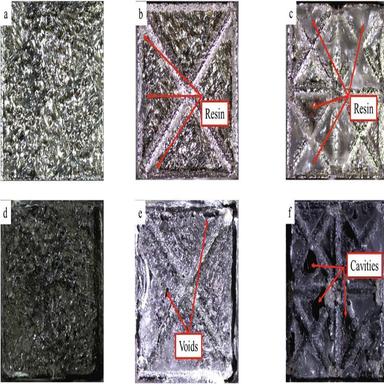
Fractured surfaces of samples infiltrated by the orthogonal configuration of tows. a), b) and c) metal side view, d), e) and f) CFRP side view; a) and d) reference (flat) sample; b) and e) big pyramid sample; c) and f) small pyramid sample.